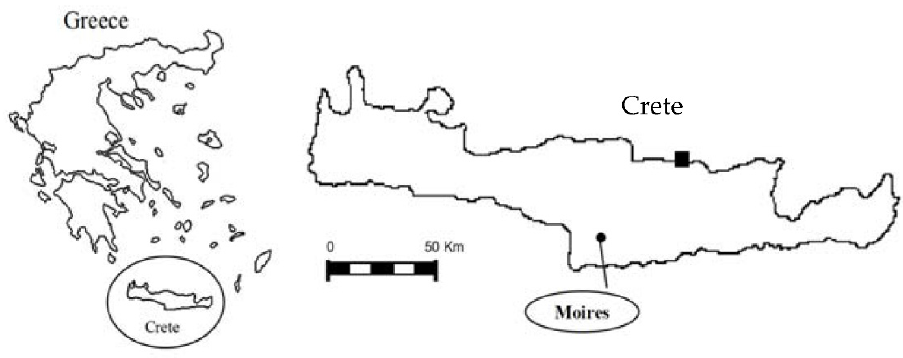
Figure 1. Location of experimental orchards in Crete, Greece.